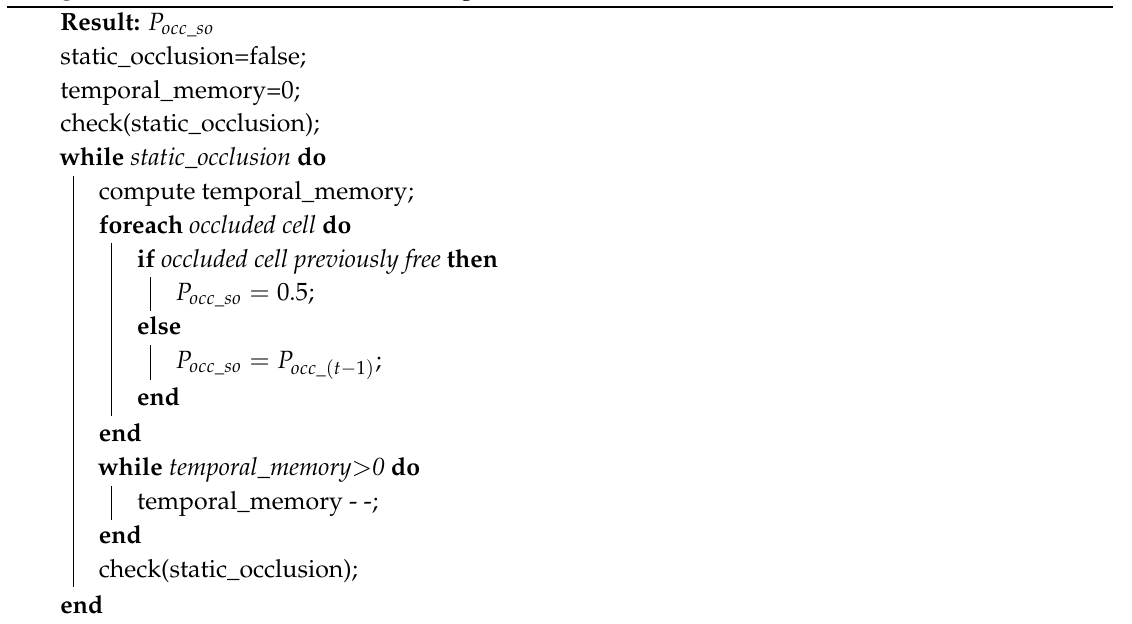
Algorithm 2: Static obstacle detector